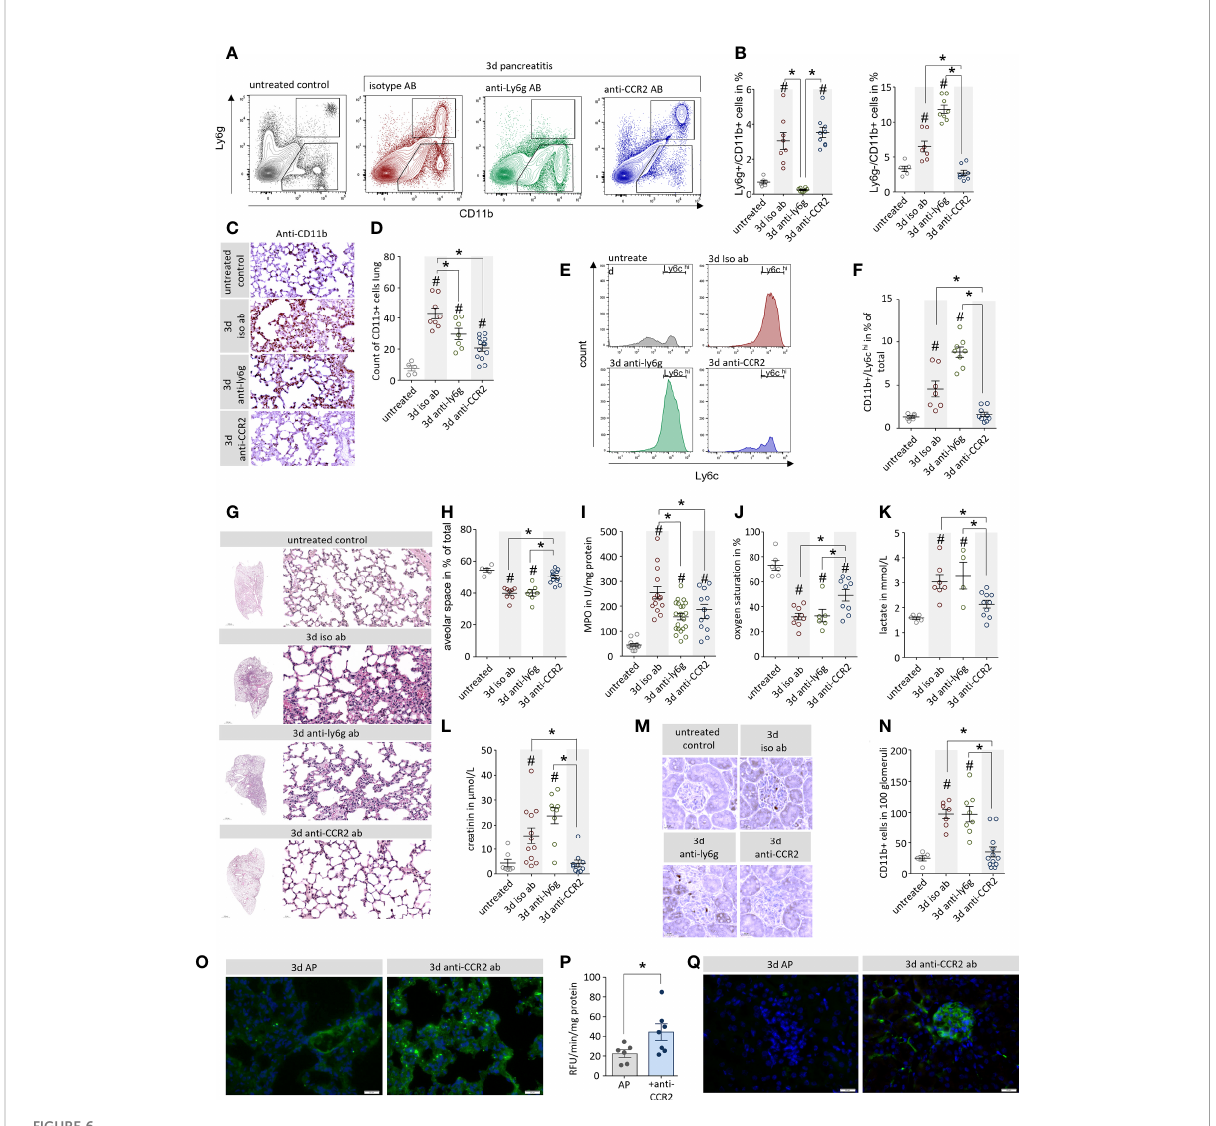
FIGURE 6 Depletion of monocytes but not neutrophils ameliorate pancreatitis-induced organ damage. (A) Leukocytes were isolated from lung tissue and analysed by fl ow cytometry using the surface markers Ly6g and CD11b. (B) 3d after the onset of AP a signi fi cant increase of CD11b + /Ly6g + neutrophils could be observed in lung tissue, this increase could be blocked by the anti-Ly6g treatment. CD11b + /Ly6g - monocytes were also increased in AP mice, this increase was blocked by anti-CCR2 treatment. (C, D) The speci fi c labelling of CD11b cells con fi rmed the fl ow cytometry results and showed signi fi cant differences after quanti fi cation. (E, F) Flow cytometry analysis of CD11b + /Ly6g - monocytes identify them as Ly6c hi cells, a marker of in fl ammatory monocytes, which were completely abolished after anti-CCR2 treatment. (G) H&E staining of lung tissue illustrates pancreatitis induced lung damage. (H) The analysis of the alveolar space/tissue volume ratio showed a signi fi cant decrease of the alveolar lung volume in mice which receive isotype ab or anti-ly6g ab, but not in the anti-CCR2 ab treated group. (I) The pancreatitis induced increase of Myeloperoxidase activity in lung was attenuated in anti-Ly6g and anti-CCR2 treated mice. (J) Oxygen saturation in arterial blood samples of AP animals was reduced, but anti-CCR2 treatment improved the sO 2 ratio compared to iso-type or anti-Ly6g treated mice. (K) Increased serum lactate in pancreatitis re fl ects a shift to anaerobic metabolism which also is ameliorated in anti-CCR2 treated mice. (L) Elevated serum creatinine levels in pancreatitis animals indicate kidney dysfunction which could also be ameliorated by anti-CCR2 treatment. (M) Labelling of CD11b in kidney sections showed reduced numbers of CD11b + cells located in the glomeruli following anti-CCR2-treatment. (N) quantitative analysis revealed signi fi cant differences in comparison to controls. (O) Visualisation of the blood circulation in the lungs by perfusion with fl uorescein conjugated concanavalin a showed a stronger staining of the capillary system in the ant-CCR2 treated group. (P) Quanti fi cation of the fl uorescent signal in lung tissue homogenate showed a signi fi cant increase in the anti-CCR2 treated group 3d after onset of disease (two-tailed students t-test for independent samples). (Q) Fluorescein conjugated concanavalin a stained the capillary system in kidney glomeruli of anti-CCR2 treated mice but not in controls 3d after induction of AP. All graphs represent 5 or more animals each group, signi fi cance was tested by one way ANOVA followed by Tukey ’ s multiple comparison test, or by Kruskal-Wallis test followed by Dunn ’ s multiple comparison test. A signi fi cance level of p<0.05 is marked by asterisk, rhombs indicate signi fi cant difference to the untreated control